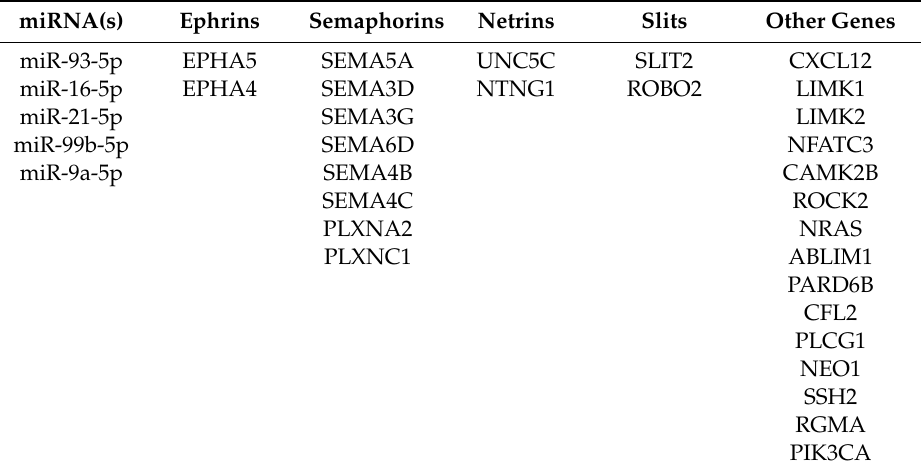
Table 4. List of genes in the axon guidance pathway targeted by five candidate